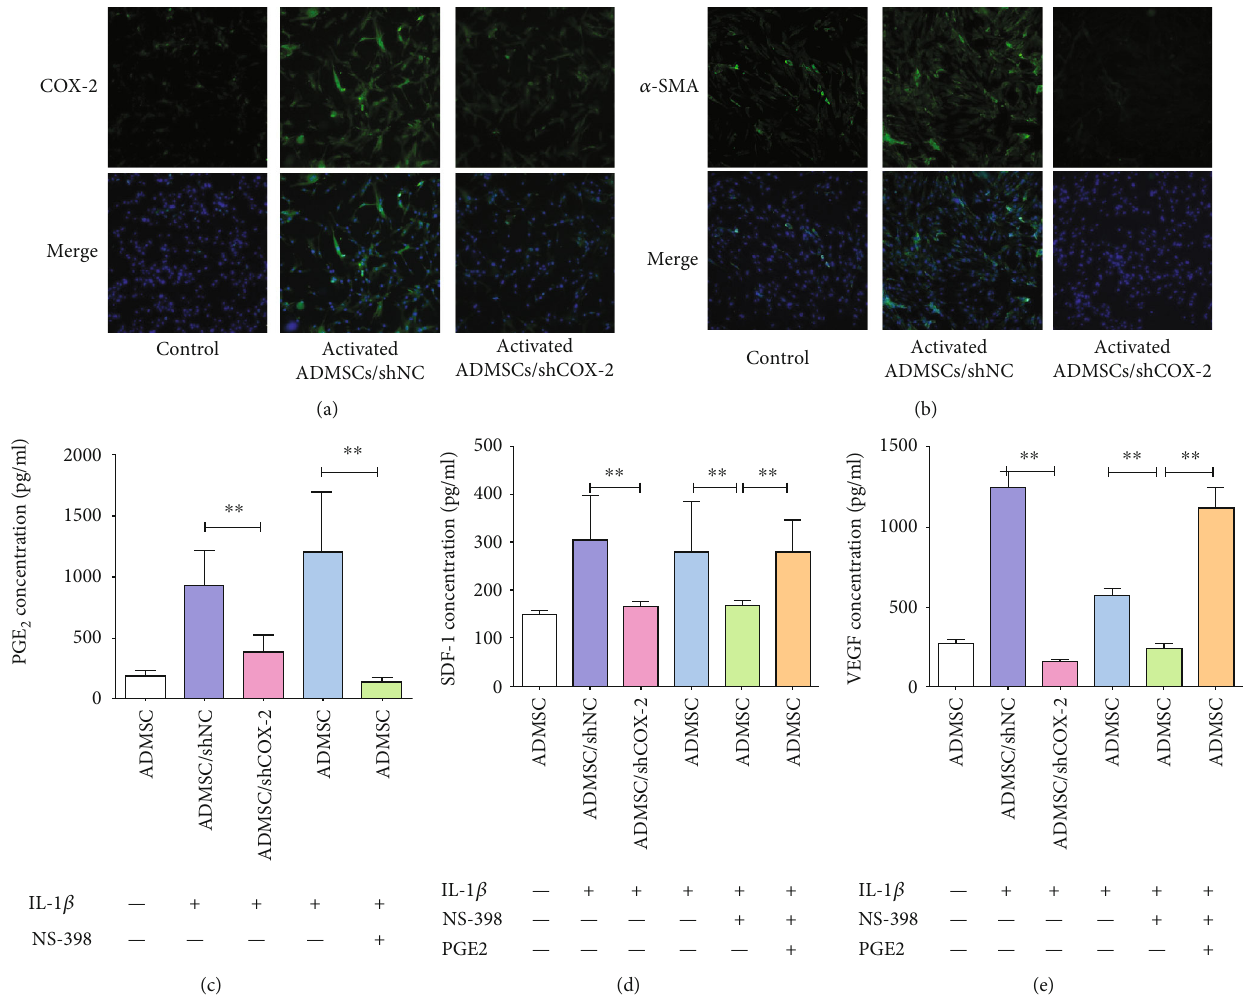
Figure 2: IL-1 β treatment activated ADMSCs dependent on COX-2-PGE signaling. (a, b) COX-2 silencing impaired the e ff ect of IL-1 β on 2 the upregulation of COX-2 and α -SMA expressions in ADMSCs. (c) COX-2 silencing impaired enhanced e ff ect of IL-1 β on PGE secretion in 2 ADMSCs. (d, e) Silencing and inhibition of COX-2 expression impaired the promoted e ff ect of IL-1 β on SDF-1 and VEGF secretion in ADMSCs, whereas exogenous PGE rescued SDF-1 and VEGF secretion when IL-1 β -pretreated ADMSCs were treated with COX-2 2 inhibitor, NS398 ( ∗∗ P < 0 : 01 , Bonferroni ’ s multiple